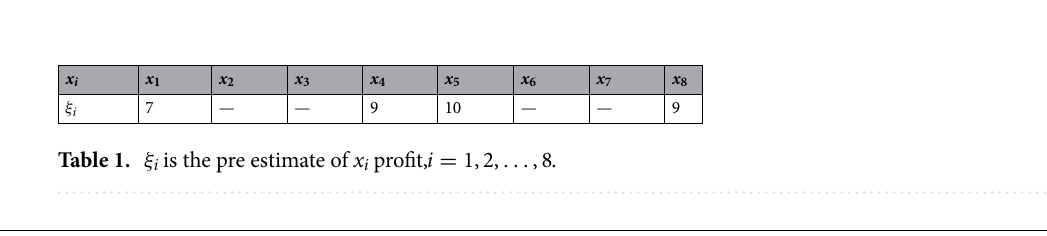
decryption algorithm